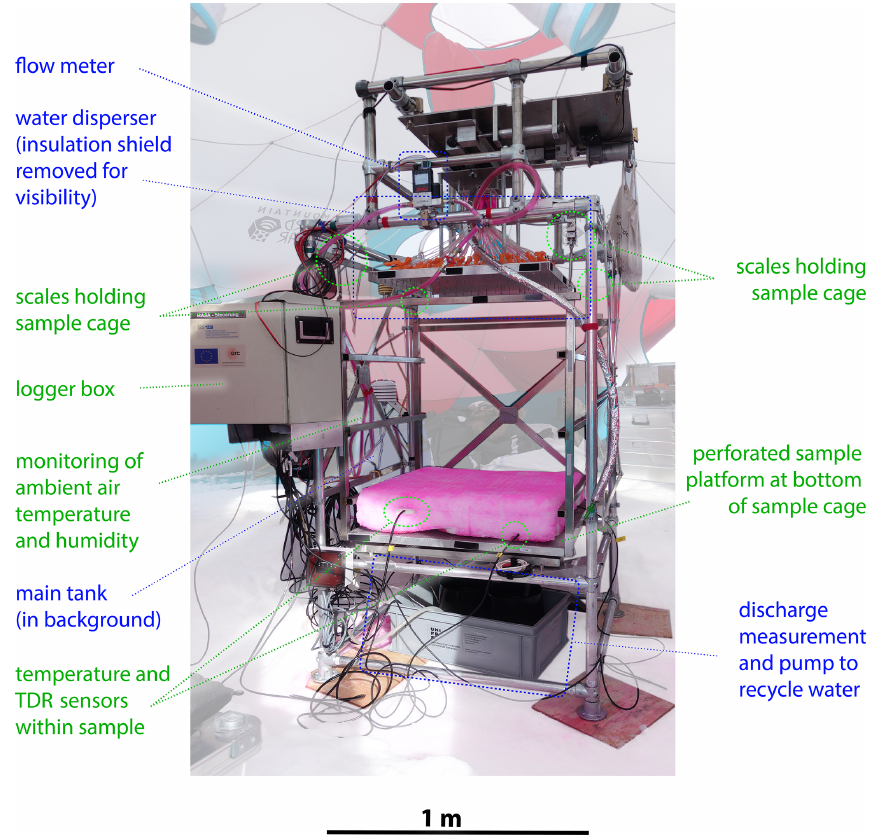
Figure 3. The rain on snow appliance (ROSA) as deployed on the Greenland Ice Sheet. Items related to the water circulation are labelled in blue; other parts are highlighted in green. Table 1. Metadata for the various meltwater percolation